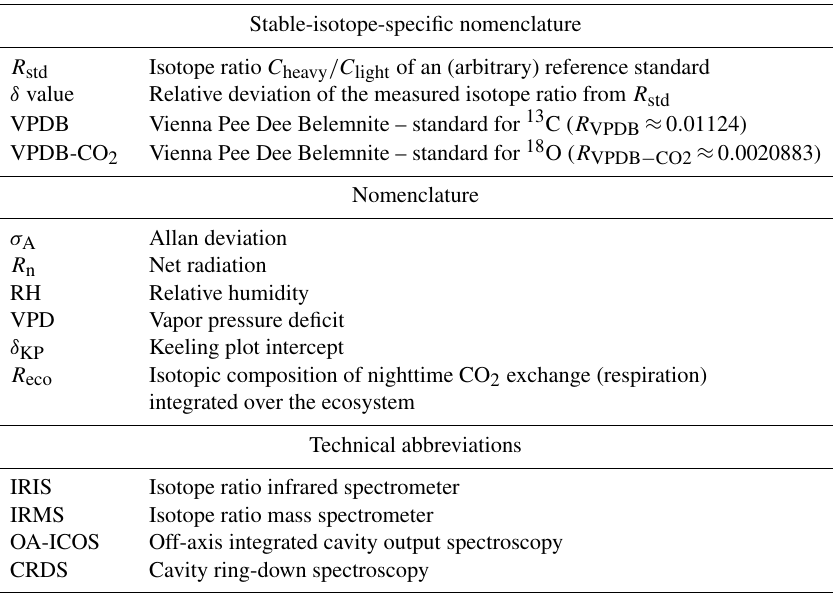
Table 1. Nomenclature and abbreviations used in this publication; numbers for reference standards R std from International Atomic Energy Agency